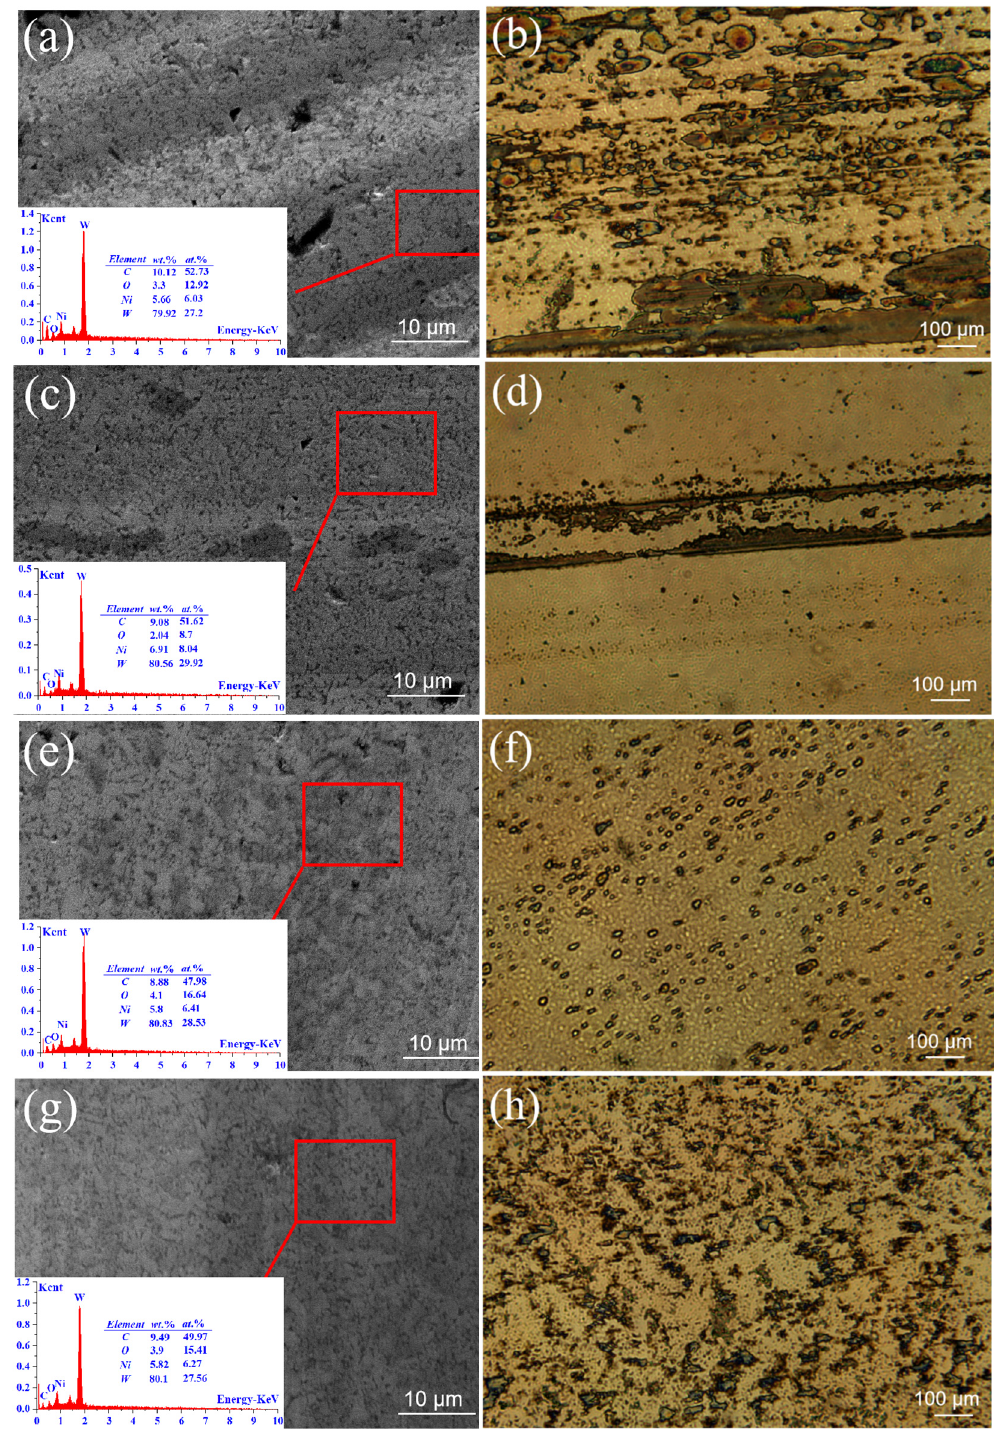
Figure 4. SEM and Microscope images of WC-Ni alloy discs. SEM images: ( a ) RT, ( c ) 200 °C, ( e ) 300 ( e ) 300 ◦ C, ( g ) 400 ◦ C; microscope:( b ) RT, ( d ) 200 ◦ C, ( f ) 300 ◦ C, ( h ) 400 ◦ °C, ( g ) 400 °C; microscope:( b ) RT, ( d ) 200 °C, ( f ) 300 °C, ( h ) 400 °C.